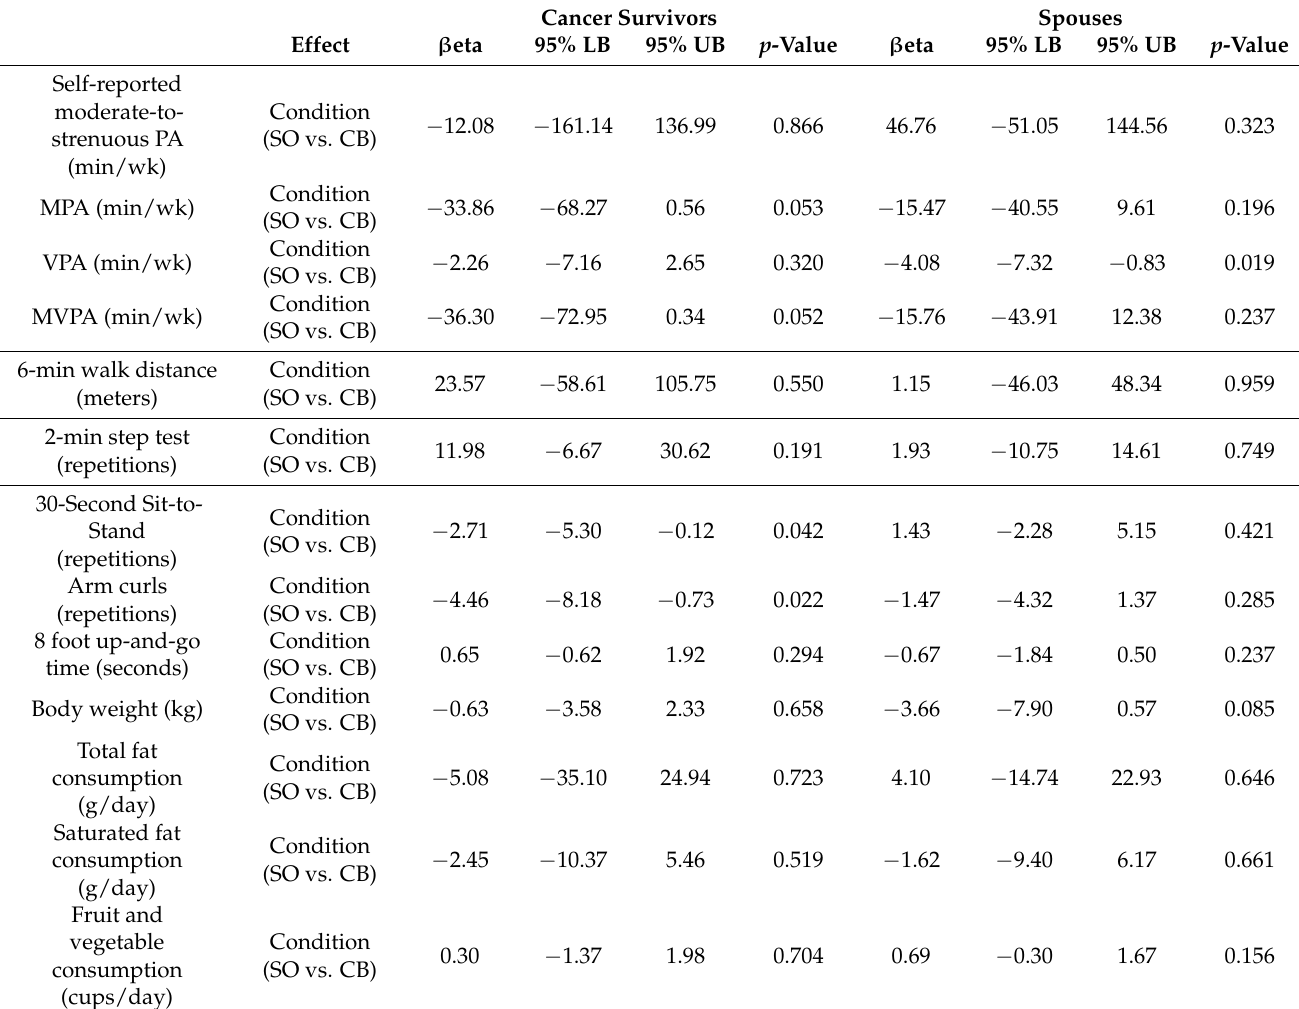
Table 3. Multiple linear regression models estimating treatment effects. Cancer Survivors